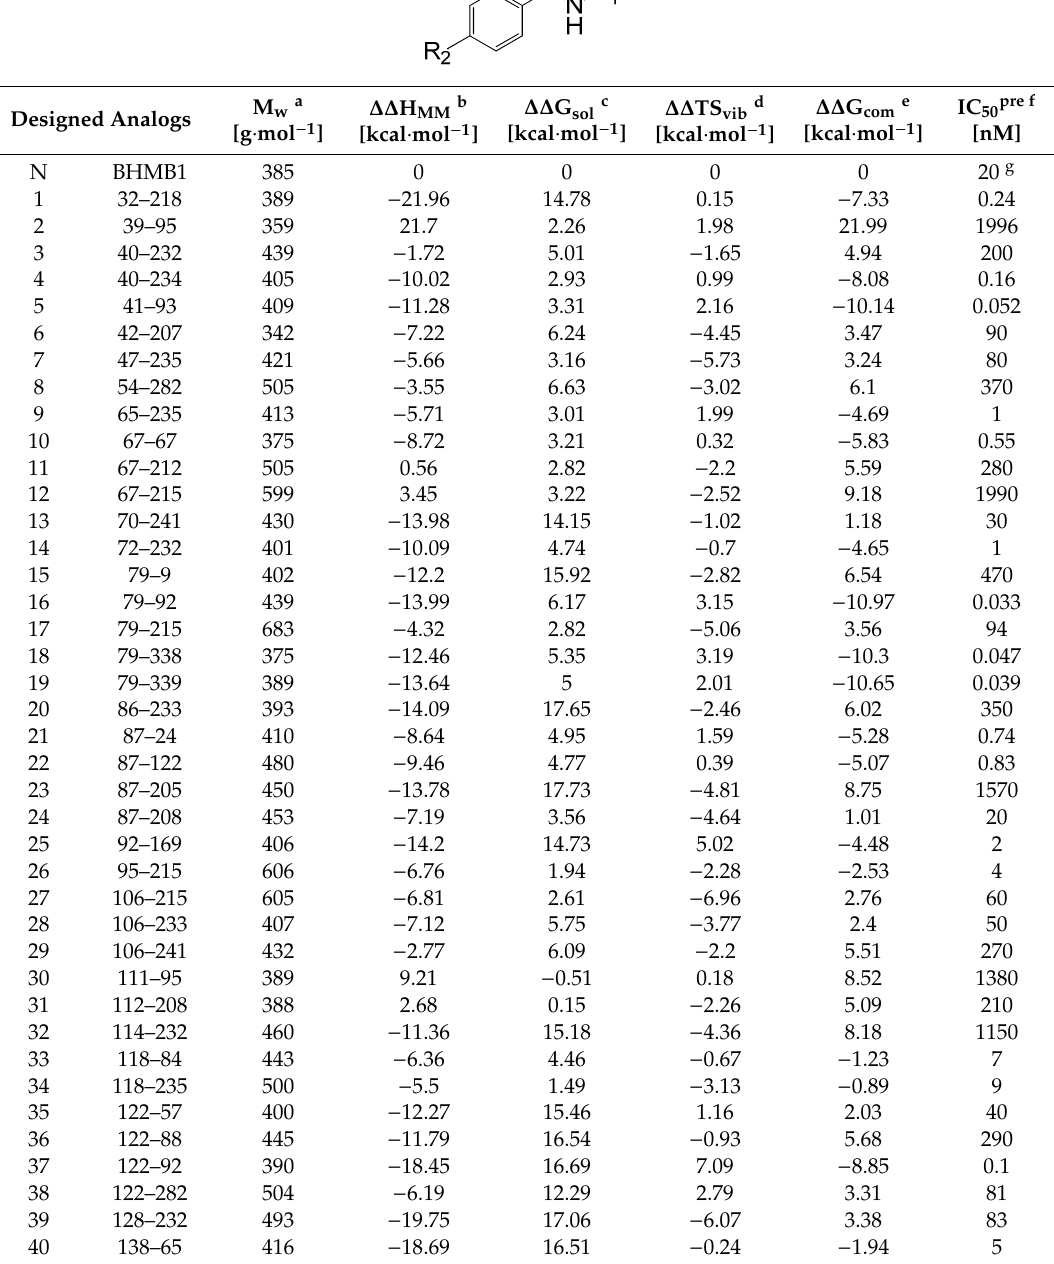
Table 6. GFE and their components for the top scoring 90 virtual BHMB analogs. The analog numbering concatenates the index of each substituent R 1 to R 2 with the substituent numbers taken from Table 5 except for hydrogen which is directly specified by the letter H.